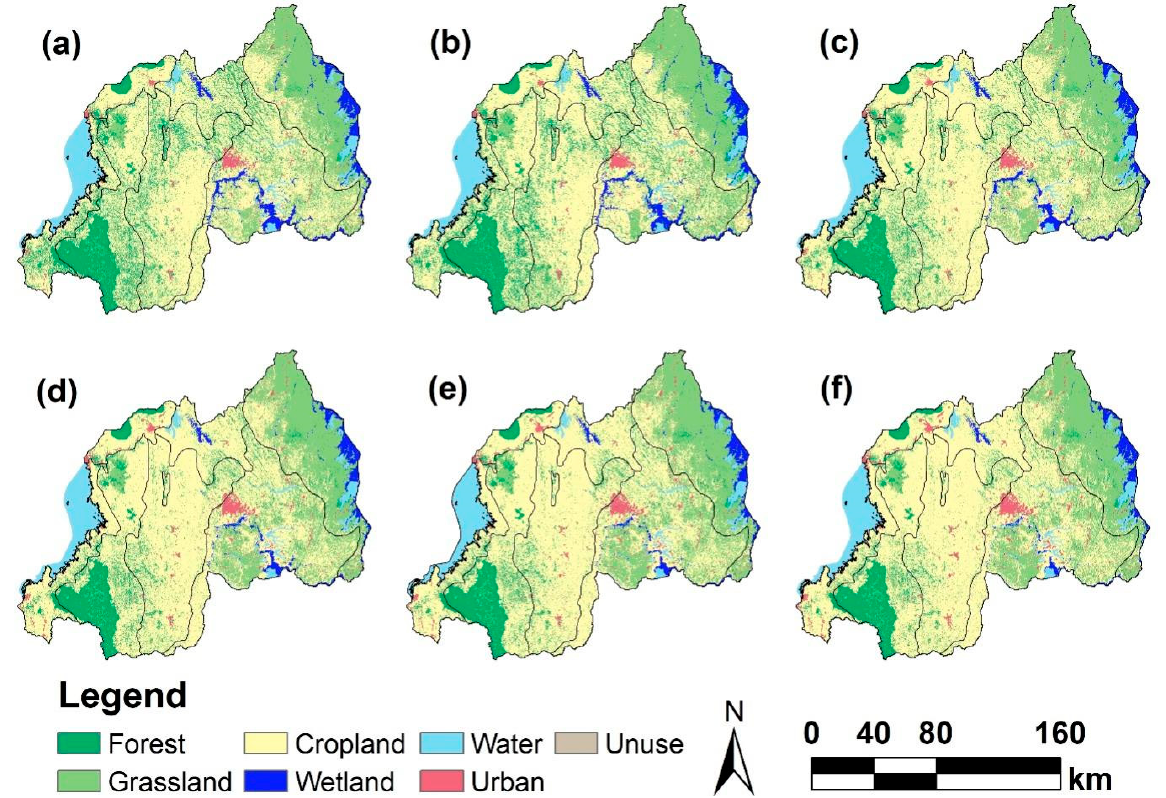
Figure 7. Land use maps of Rwanda for the period 2015–2050; ( a ) observed LULC in 2015; ( b ) scheme 2015. ( c ) simulated LULC in 2020; ( d ) simulated LULC in 2030; ( e ) simulated LULC in 2040; ( f ) simulated LULC in 2050.